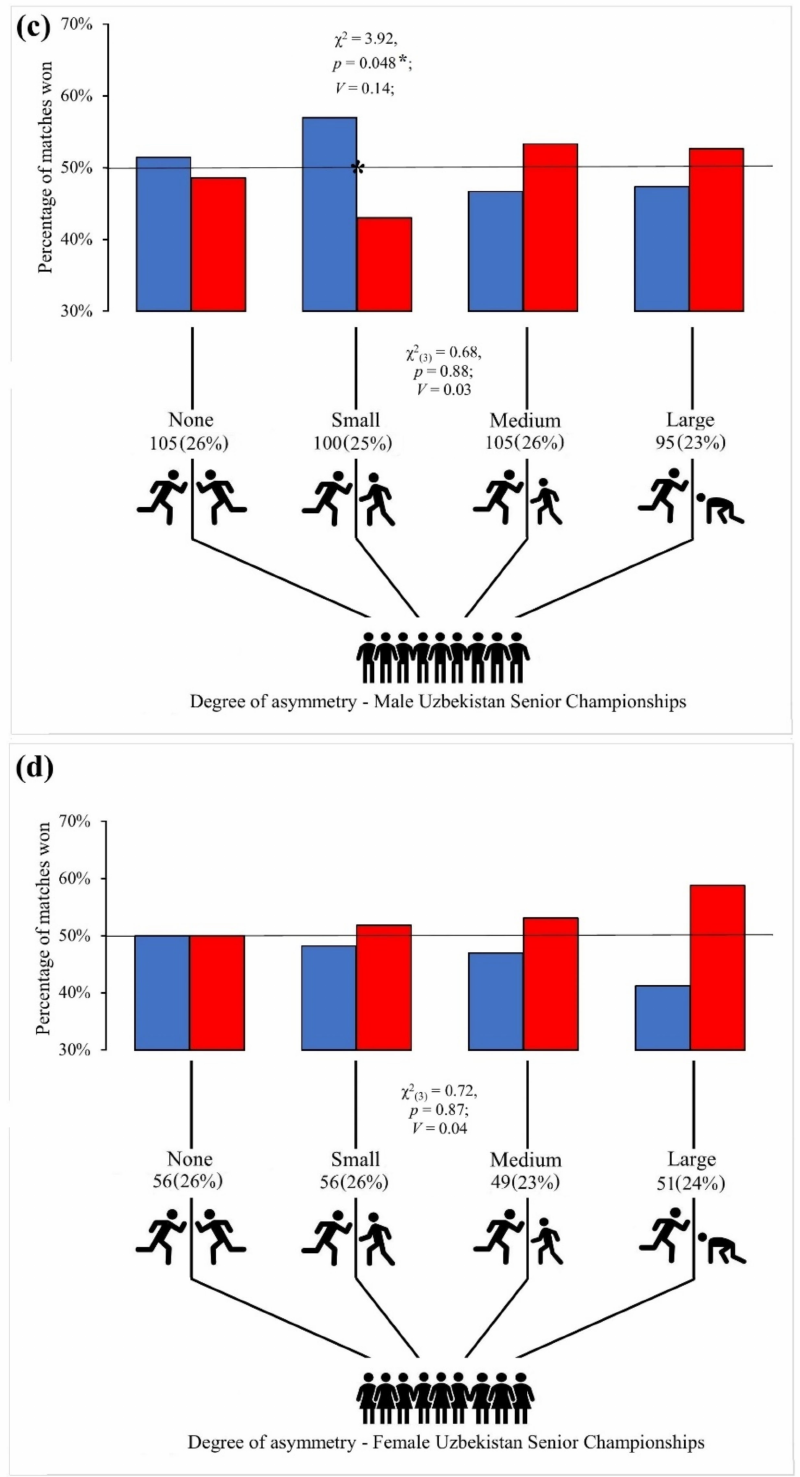
Figure 1. Percentage (%) of taekwondo matches won by athletes according to their color of protectors (blue and red) given different degrees of relative ability (asymmetry) in the two athletes in each match. ( a ) Male ITA-SC; ( b ) Female ITA-SC; ( c ) Male UZB-SC; ( d ) Female UZB-SC. Black lines at 50% indicate the expected percentage of wins by blue and red under the null hypothesis that the color is not associated with the outcome of the match. χ 2 : chi-square; * significant association between the color of the protectors and the winning of the match (* p < 0.05; ** p < 0.01); V : Cramer’s V